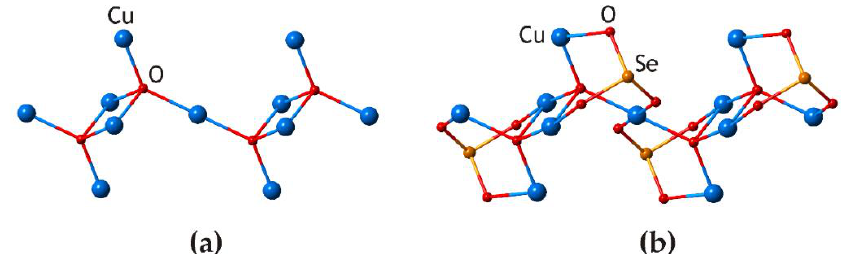
Figure 4. The basic structural module for the crystal structures of the Cu 5 O 2 (SeO 3 ) 2 Cl 2 polymorphs (georgbokiite and parageorgbokiite): ( a ) the [O 2 Cu 5 ] chain formed by alternating edge- and corner-sharing (OCu 4 ) tetrahedra; ( b ) the {[O 2 Cu 5 ](SeO 3 ) 2 } 1-dimensional module formed by the face-to-face attachment of (SeO 3 ) groups to (OCu 4 ) tetrahedra.